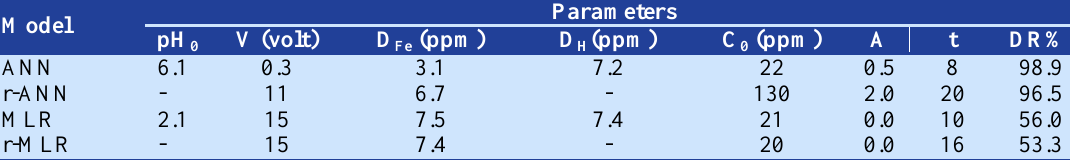
Table 5. Genetic algorithm optimization result